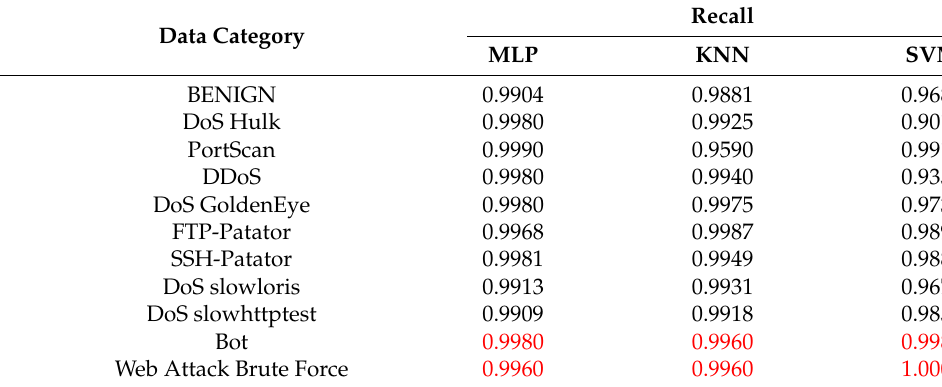
Table 5. Identification results of the expanded dataset.